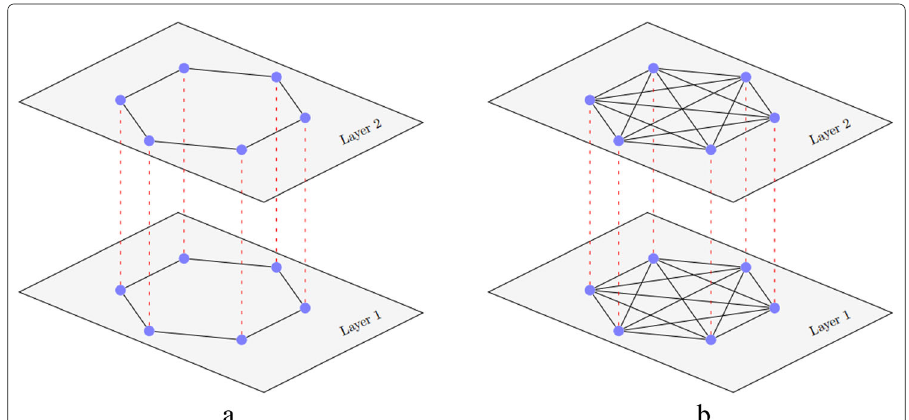
Fig. 1 Examples of the diagonal interlink configuration. Each network is formed by two equal subnetworks with N 0 = 6 nodes each and, with ( a ) ring and ( b ) all-to-all topology. The solid black and dashed red links correspond to the intra and inter-connections,